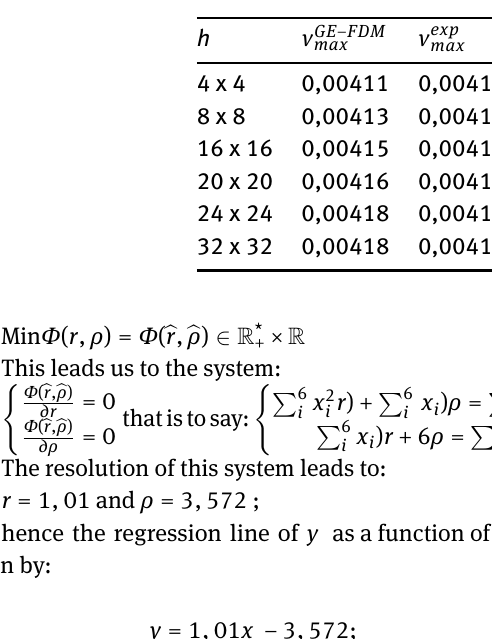
Table 2: Values of the relative error of v max .